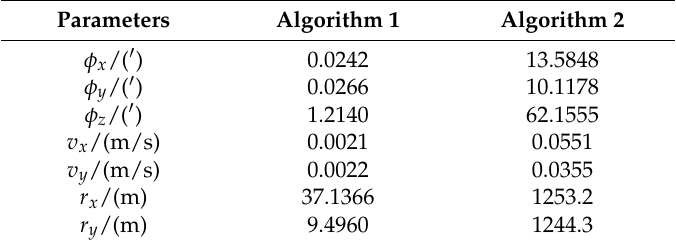
Table 3. RMS errors of Algorithm 1 and Algorithm 2 in the